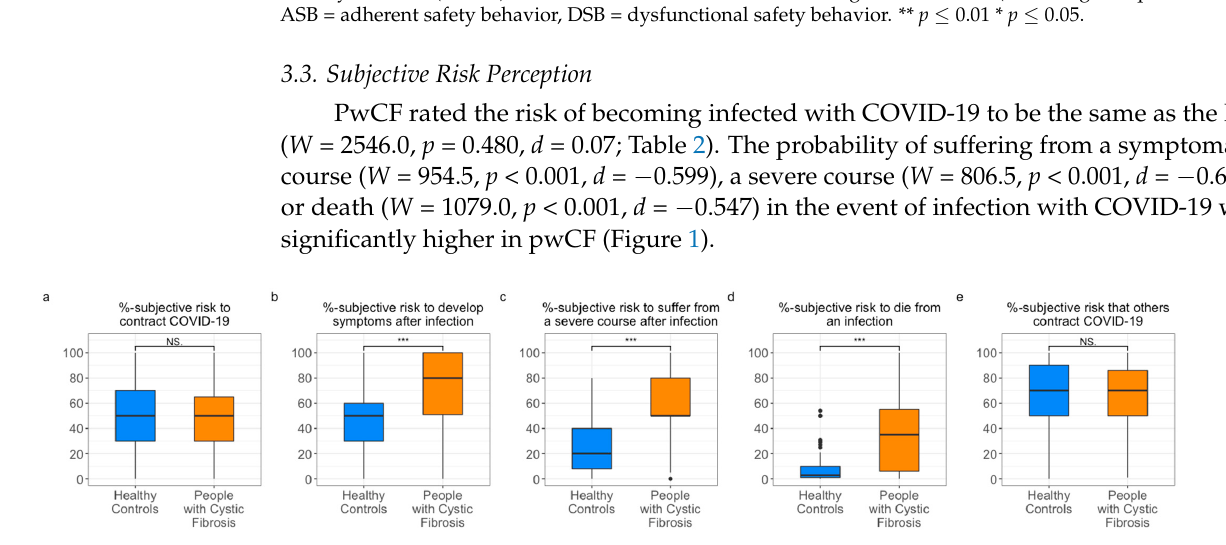
Figure 1. Distribution of risk perception, in percent (%), in people with cystic fibrosis (pwCF) compared to healthy controls (HC), regarding ( a ) risk of infection with COVID-19, ( b ) presenting symptoms of COVID-19, ( c ) having a severe course of COVID-19, ( d ) risk of dying of COVID-19, and ( e ) risk that others contract COVID-19. For descriptive statistics see Table